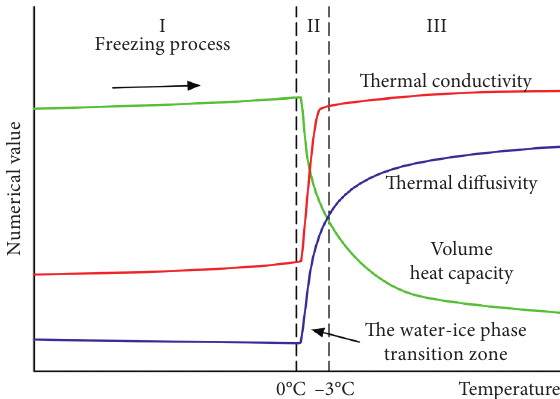
Figure 3: Schematic diagram of the thermal properties of loess as a function of (T) during freezing.